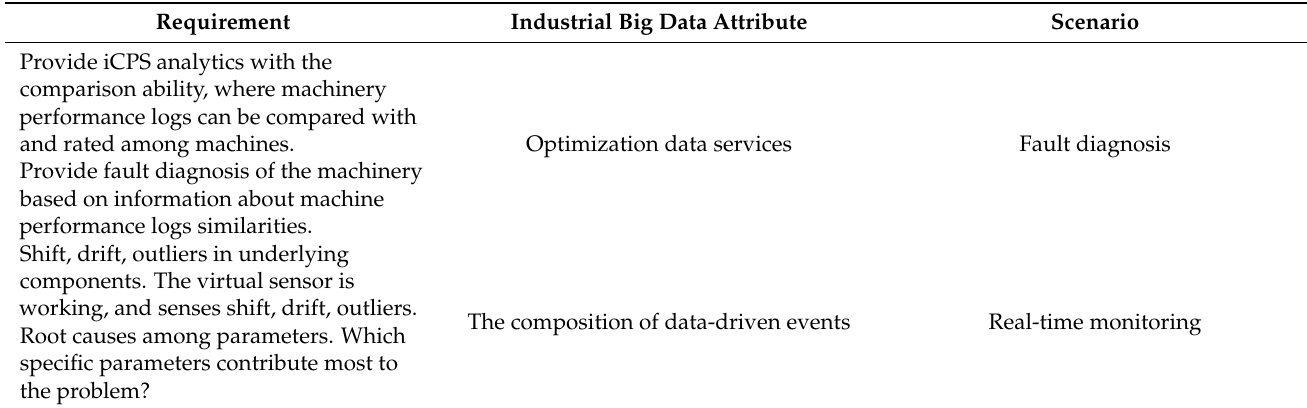
Table 3. Requirements of fault diagnosis scenarios.